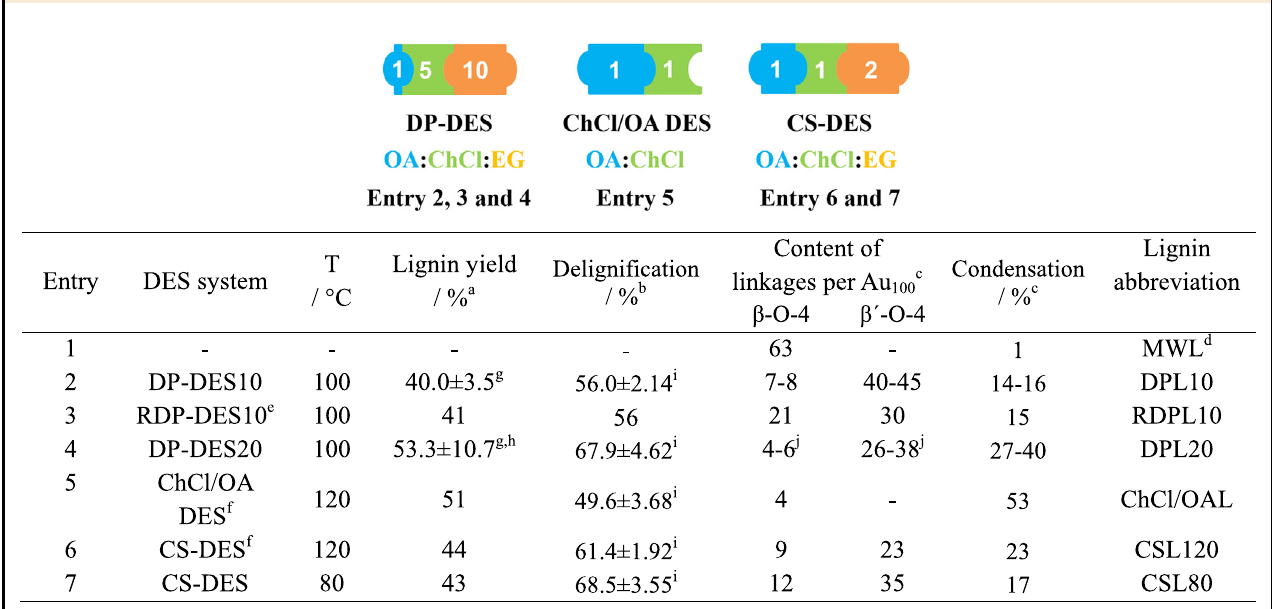
Table 1 Yield and semi-quantitative analysis of lignins obtained by various DES treatments of birch lignocellulose.